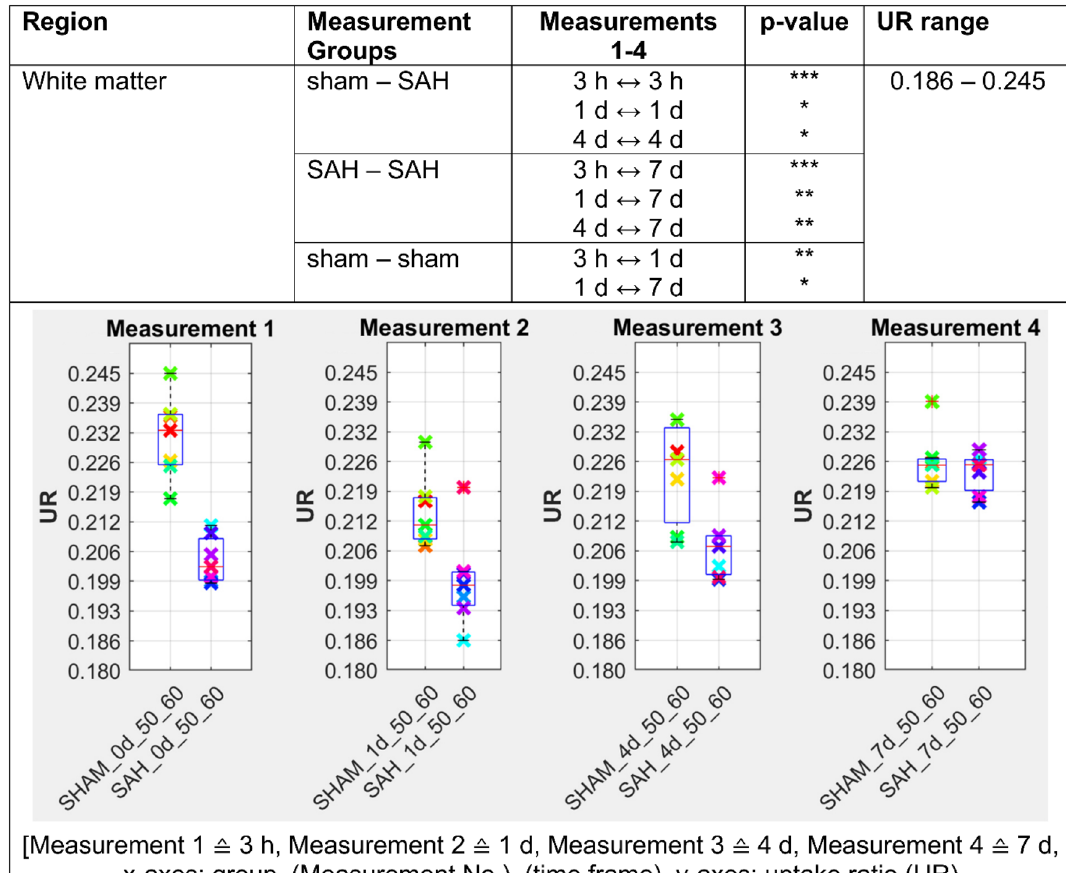
Figure 3. [ 18 F]FDG uptake ratio is highly significant (p ≤ 0.001) reduced in white matter in SAH animals compared to the sham operated group 3 h following the SAH/sham operation. The UR of SAH animals remained significantly (p ≤ 0.05) reduced in white matter up to day 4 following SAH but converges strongly on day 7. p ≤ 0.05 *; p ≤ 0.01 **; p ≤ 0.001